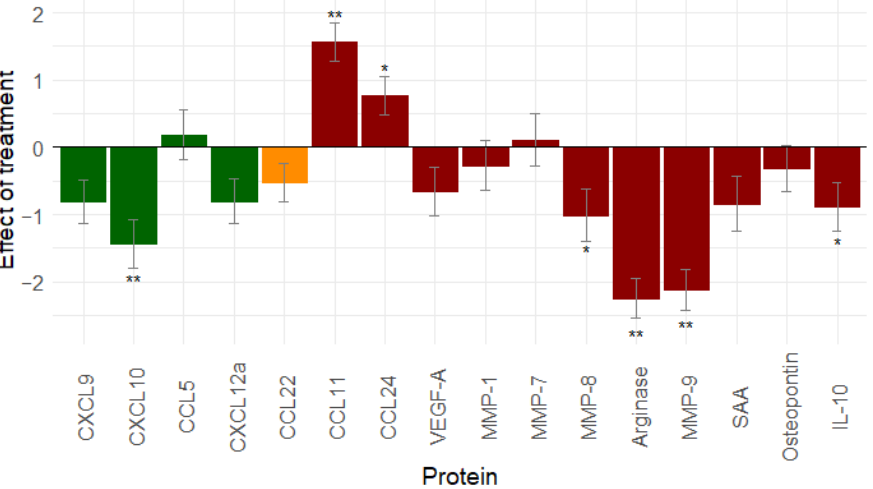
Figure 4. Effect of total primary treatment ( n = 66) on immune related proteins: primary treatment of ovarian cancer gives a pronounced decrease in immunostimulation and immunosuppression. (Similar results are seen when leaving out stage I ovarian cancer patients, see Figure S6.) Proteins in green are immune stimulatory factors, proteins in red are immune inhibitory factors, and proteins in orange have dual function. *: 0.01 ≤ p -value < 0.05; **: p -value < 0.01. Abbreviations: CCL, C-C motif chemokine ligand; CXCL, C-X-C motif chemokine ligand; IL-10, interleukin-10; MMP, matrix metallopeptidase; SAA, serum amyloid A; vascular endothelial growth factor (VEGF). Table 2. Effect of the sequence in chemotherapy and debulking surgery on the immune